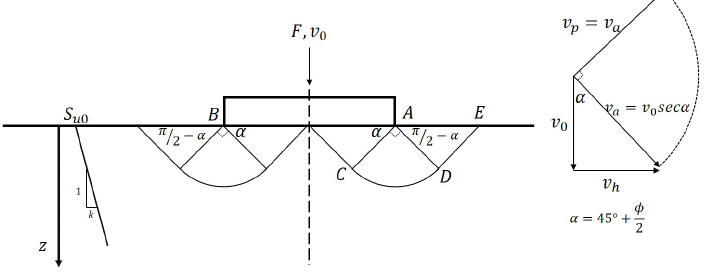
Figure 7. Velocity field with a radial zone for a perfectly smooth footing on homogeneous cohesive soil